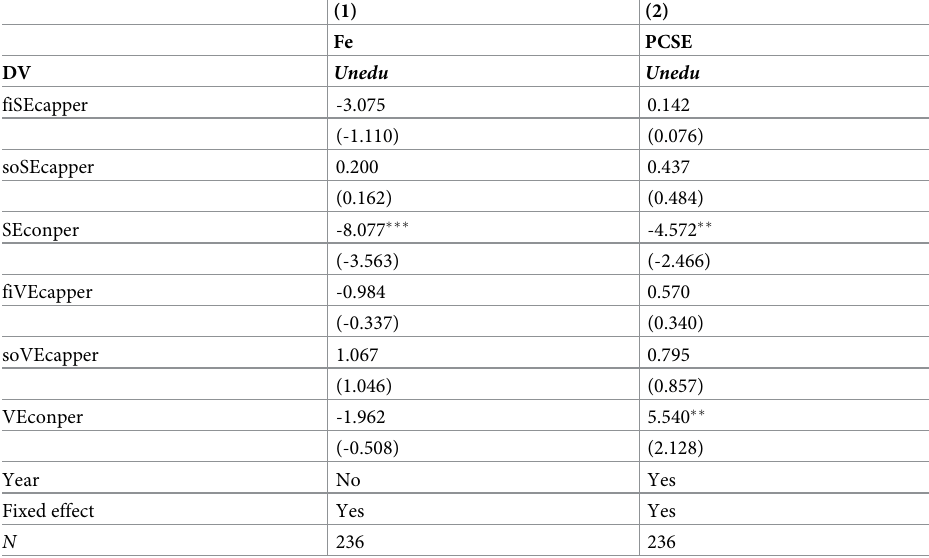
Table 11. The results of capital expenditures on RSE correction with